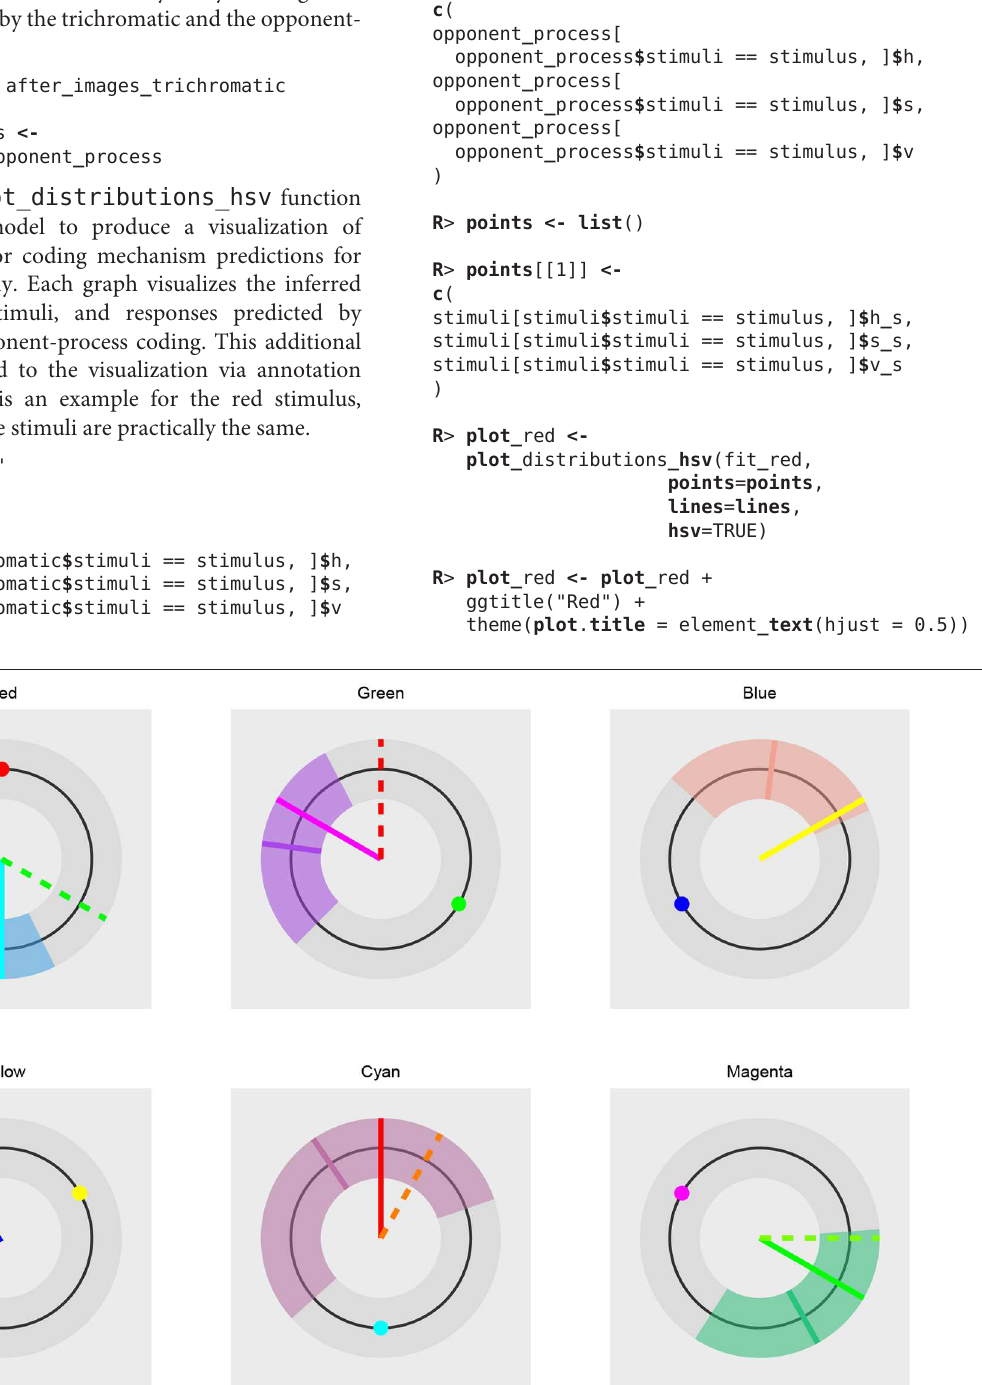
Frontiers in Psychology |